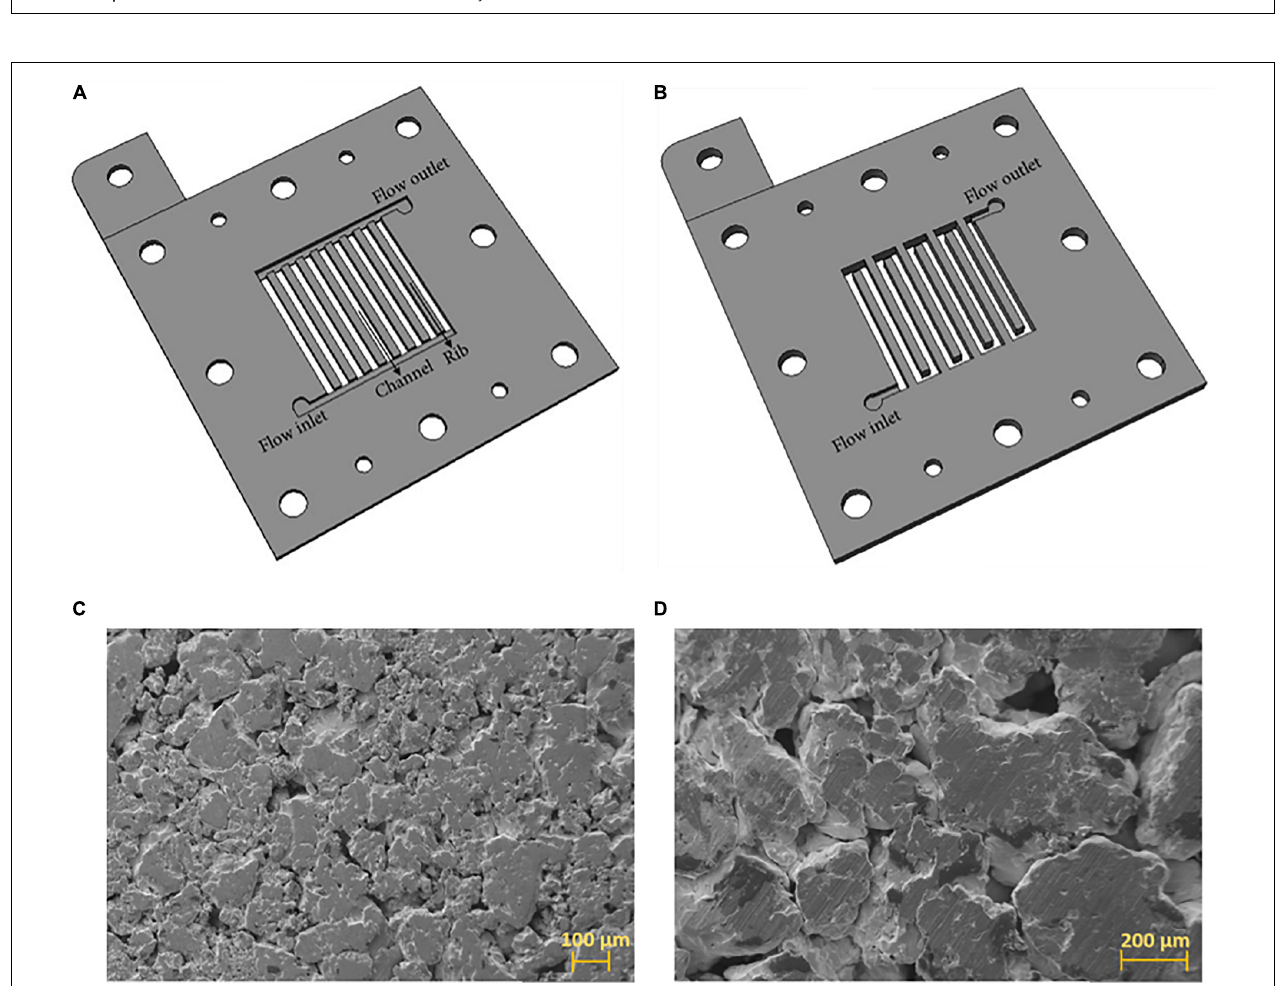
FIGURE 2 | (A) Parallel flow-field design (PFF), (B) single–serpentine flow-field design (SSFF) (C) SEM image of the SP-PTL with an average pore diameter of 16 µ m at 200 × magnification (D) SEM image of the LP-PTL with an average pore diameter of 60 µ m at 200 × magnification.